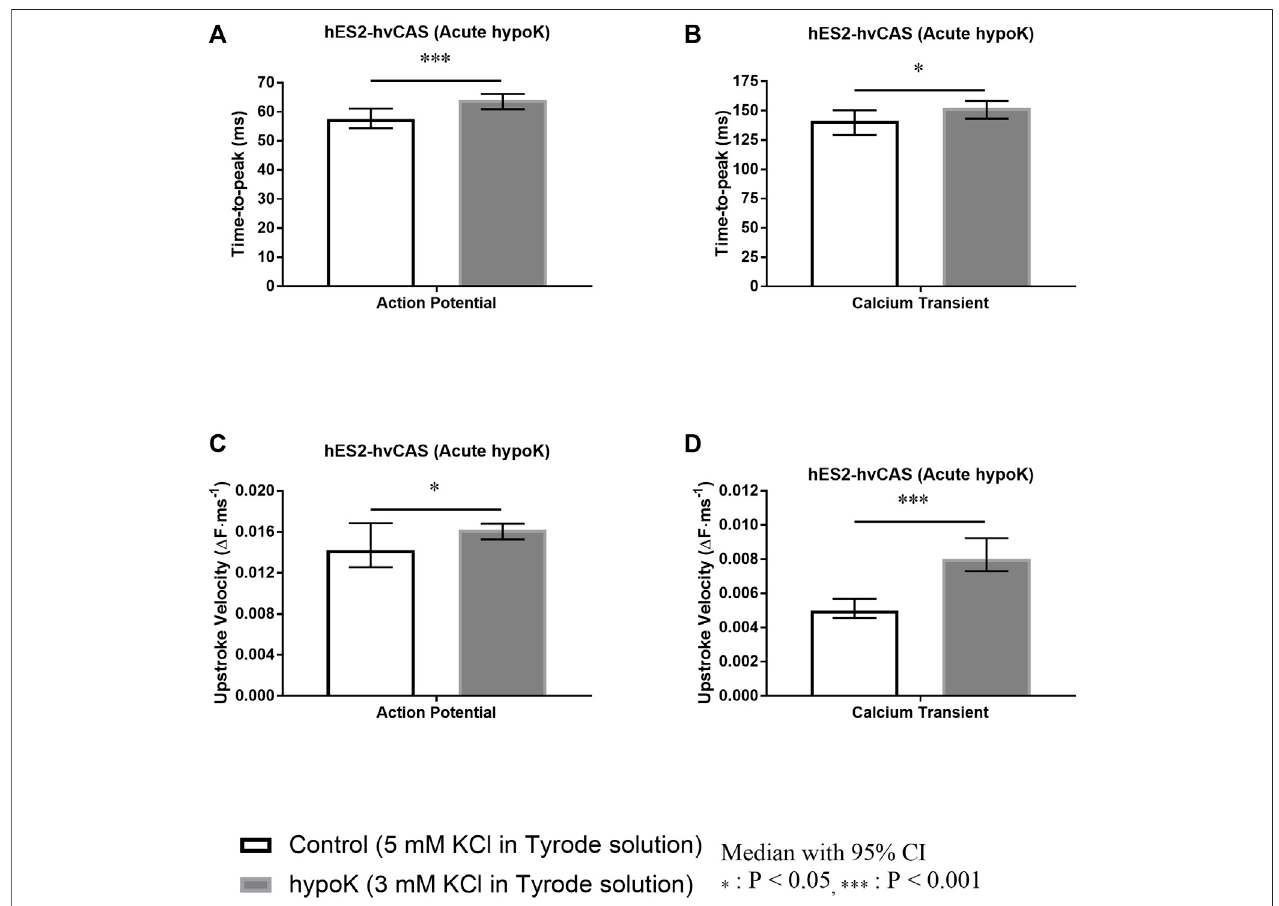
FIGURE 4 | Human embryonic stem cell (hES2)-derived human ventricular cardiac anisotropic sheet (hvCAS) paced at 1.5 Hz during acute hypokalaemic (hypoK) experiment where the treatment was for 15 min before data acquisition. Number of samples is represented by n where the fi rst number refers to control (5 mM KCl in Tyrode solution) samples and the second number refers to hypoK (3 mM KCl in Tyrode solution) samples. (A) Action Potential (AP) Time-to-peak. ( n (cid:1) 14, 17). (B) Calcium Transient (CaT) Time-to-peak. ( n (cid:1) 12, 11). (C) AP Upstroke Velocity measured by the change in fl uorescence intensity per millisecond. Δ F represents the change in fl uorescence intensity. ( n (cid:1) 9, 10). (D) CaT Upstroke Velocity measured by the change in fl uorescence intensity per millisecond. Δ F represents the change in fl uorescence intensity. ( n (cid:1) 11, 10) Time-to-peak of AP and CaT increased in hypokalaemic condition (asterisks, p < 0.001, p < 0.05 respectively). Similarly Upstroke Velocity of AP and CaT increased in hypokalaemic condition (asterisks, p < 0.05, p < 0.001 respectively).